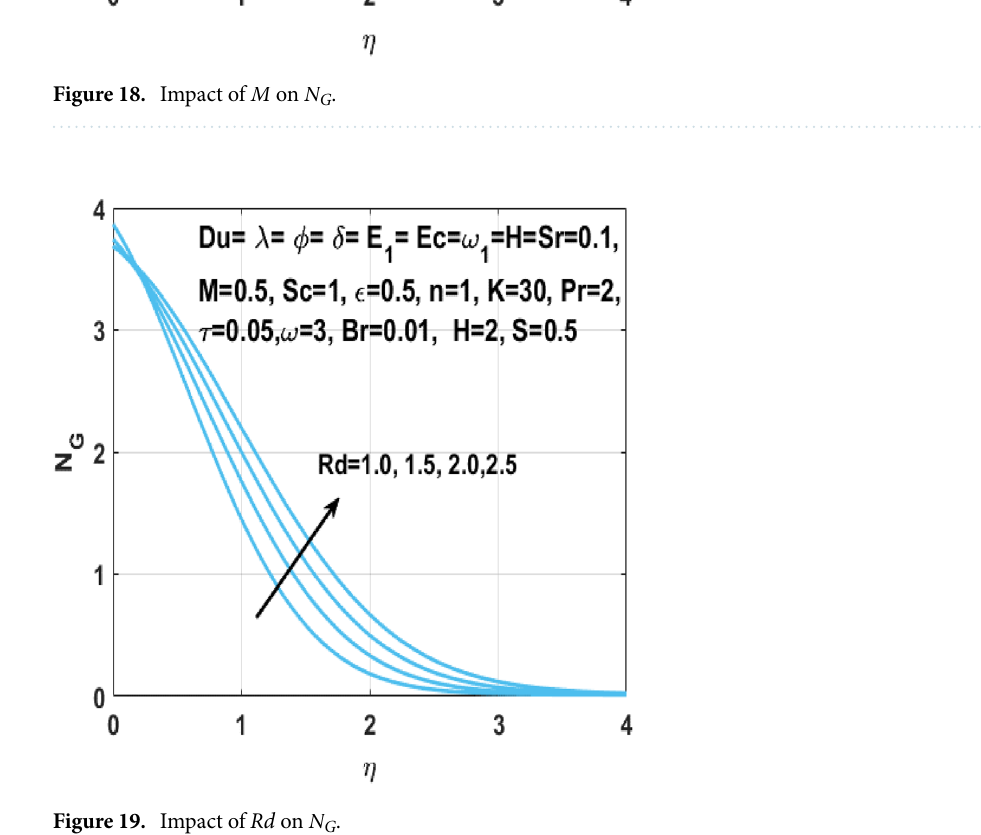
Figure 19. Impact of Rd on N G